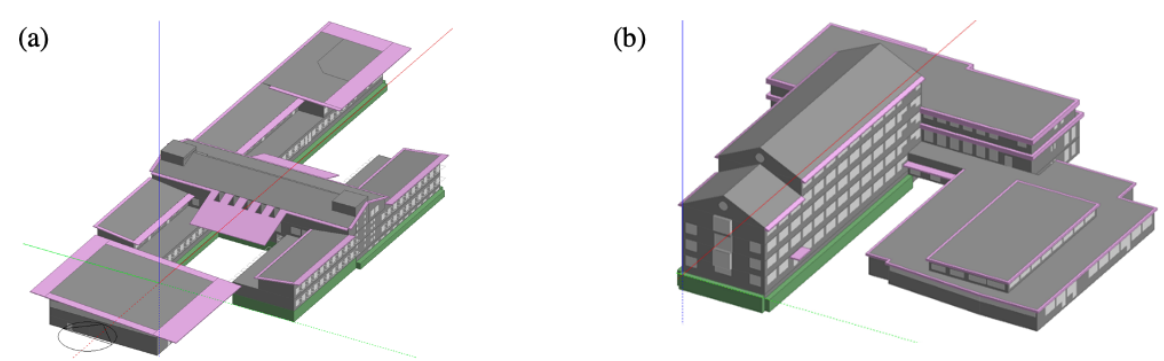
Figure 1. Models created in DesignBuilder concerning: (a) SB #1; (b) SB